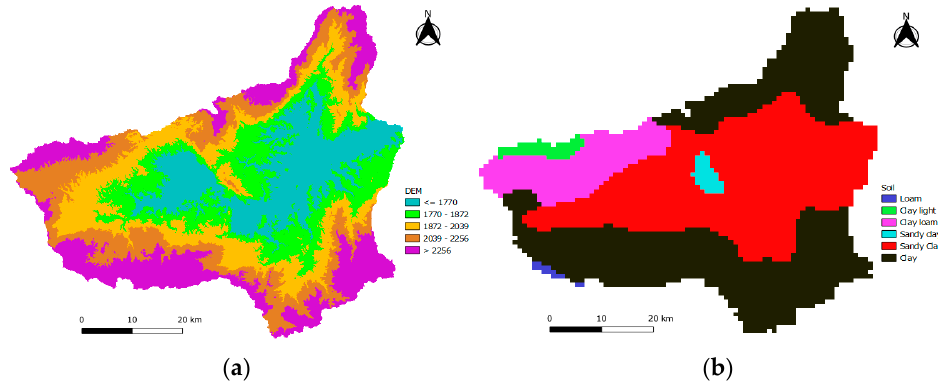
Figure 1. Study area maps of ( a ) digital elevation model (DEM), and ( b )